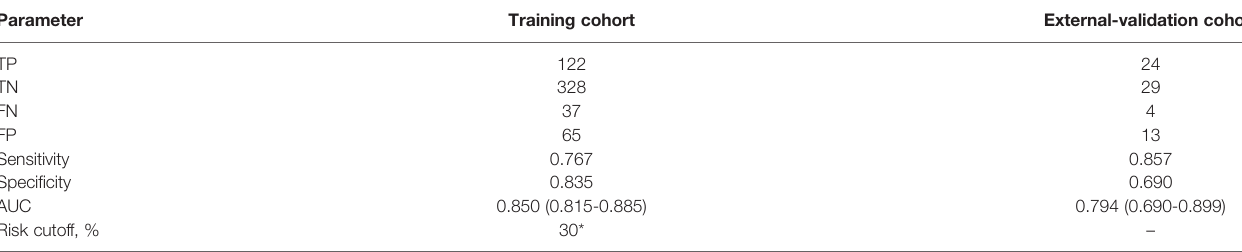
TABLE 3 | Performance evaluation of the prediction model.